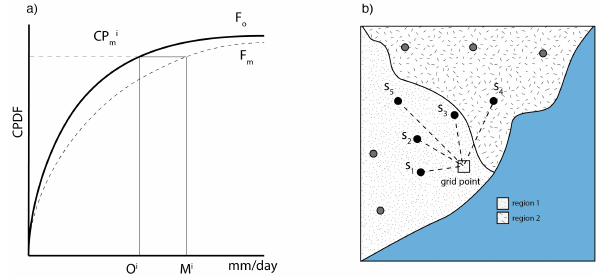
Fig. 3. (a) Schematic of the bias correction proposed by Piani et al. (2010a). Mi is the intensity of an event in the model and Oi is intensity of an observed event with the same cumulative probability (CPmi) as defined by Fm and Fo, which are the cumulative proba- bility functions for the model and the observations. (b) Schematic of the adaptation of the bias-correction method using stations and